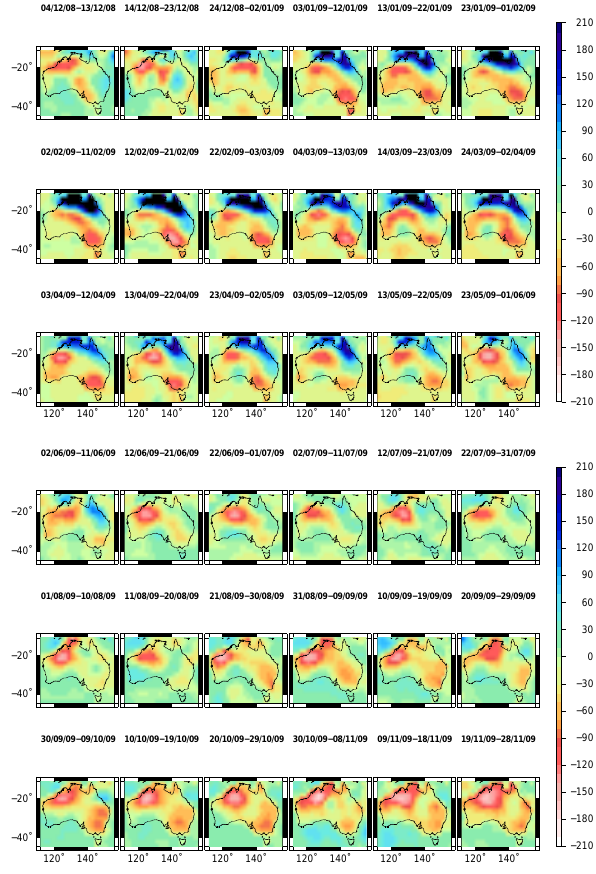
Fig. 3. Time series of regional maps of water mass from December 2008 to November 2009. We can notice the annual signal with amplitude of ± 250mm of EWH representing the alternating wet and dry seasons. Fig. 4. (a) Linear trends and (b) annual amplitudes derived from GRACE-based regional solutions for 2003- 2009.